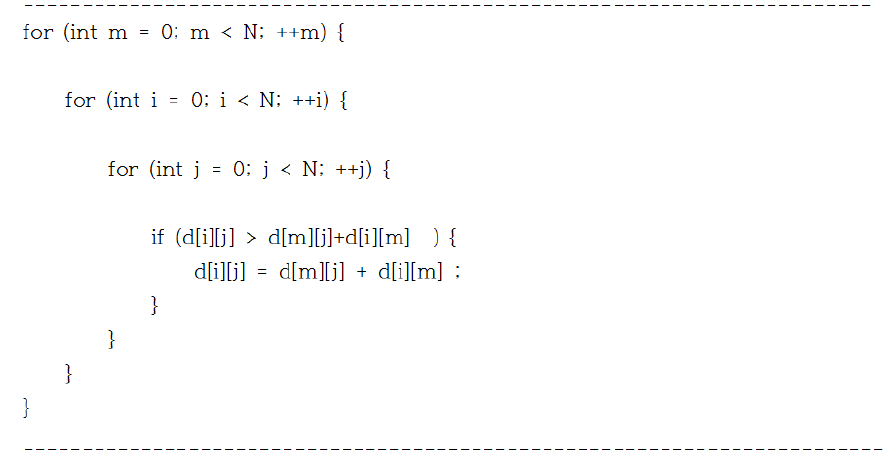
Figure 16. Floyd – Warshall algorithm. Figure 16. Floyd–Warshall